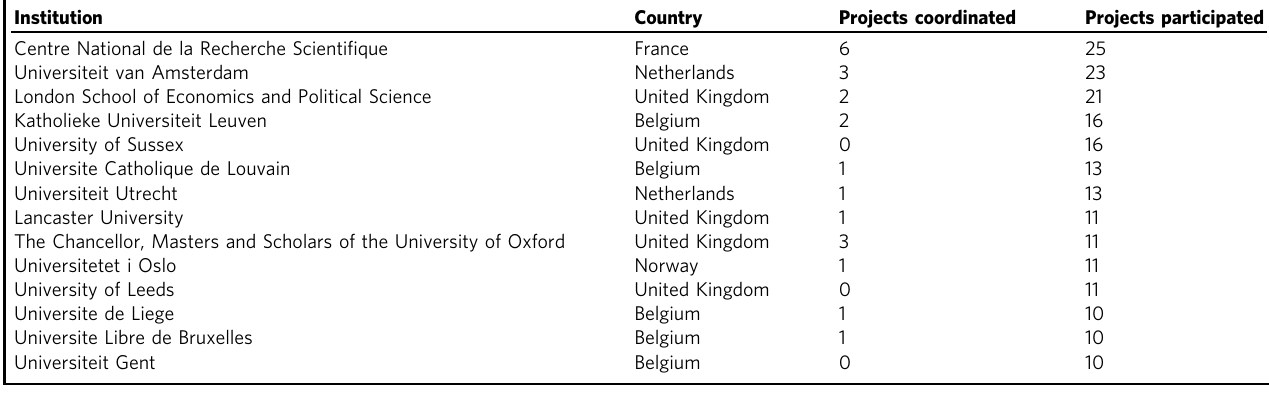
Table 5 Participation of institutions in social sciences and humanities projects funded under FP6.